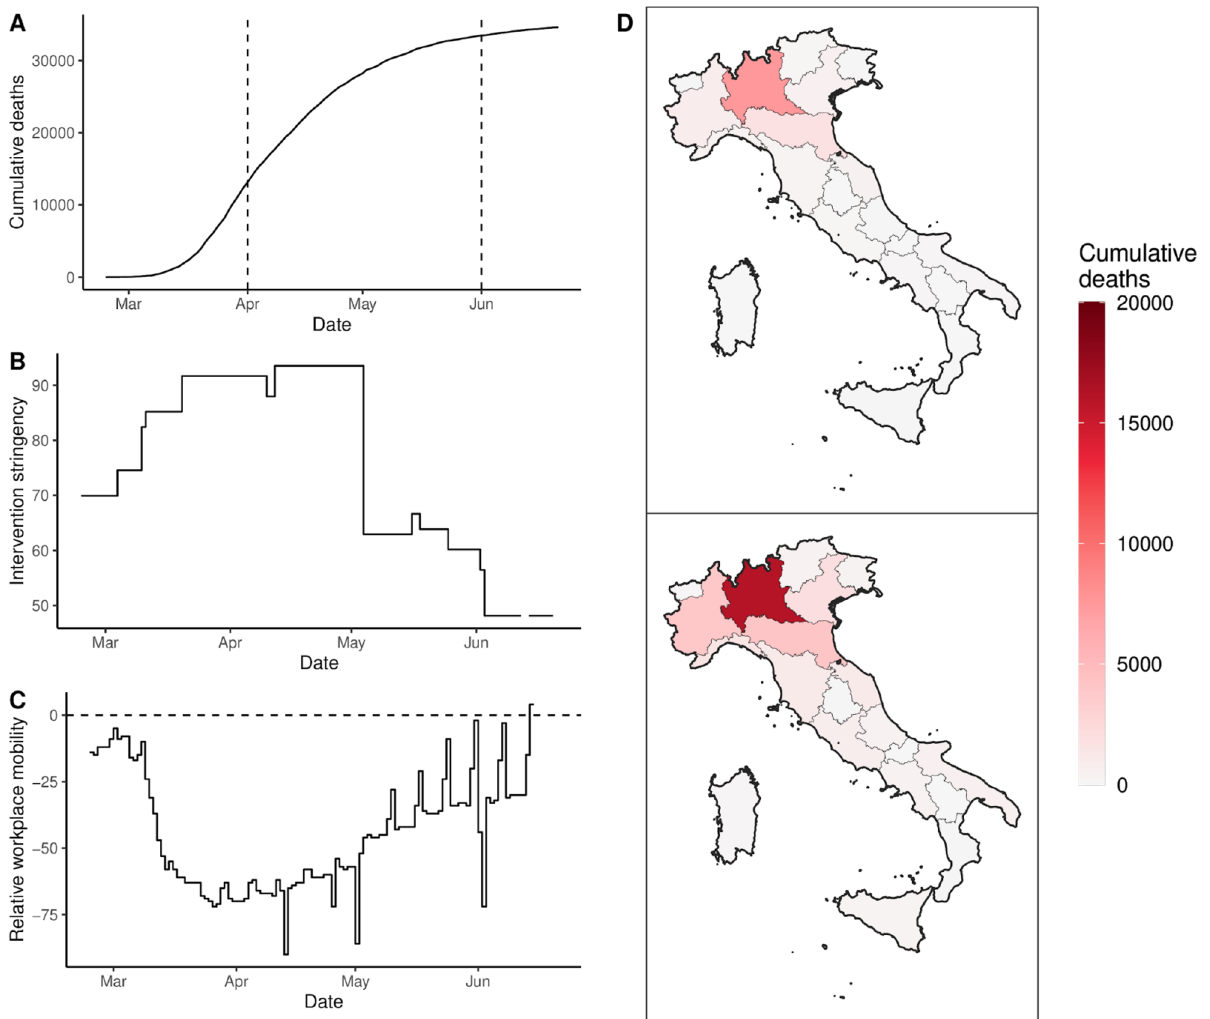
Figure 2. Sample data for Italy demonstrating the data types that are provided by OxCOVID19 Database. ( A ) the cumulative number of deaths through time with two time points (corresponding to 1st of April and 1st of June) indicated by dashed lines. ( B ) the intervention stringency, which is further stratified by the precise type of non-pharmaceutical interventions 4 . ( C ) the relative mobility for workplace activity from Google, the dashed line corresponds to parity with historical values. Panel ( D ) the spatial distribution of the cumulative number of deaths across Italy on the April 1 and June 1, 2020, which corresponds to the dashed lines in ( A ). The choropleth map of Italy was generated with R (https:// www.R- proje ct. org, version 4.0.2) 16 . The spatial geometries were obtained using GADMTools 17 and the figures were generated using ggplot2 (https:// ggplo t2. tidyv erse. org, version 3.3.2) 18 and ggspatial (https:// CRAN.R- proje ct. org/ packa ge= ggspa tial, version 1.1.3) 19 .